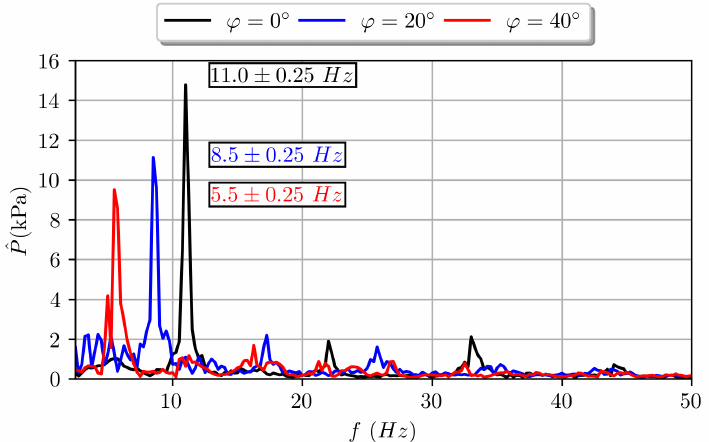
Figure 7. Unsteady pressure average spectrum for the last stable operating point at IGV stagger angles of 0 ◦ , 20 ◦ , and 40 ◦ .